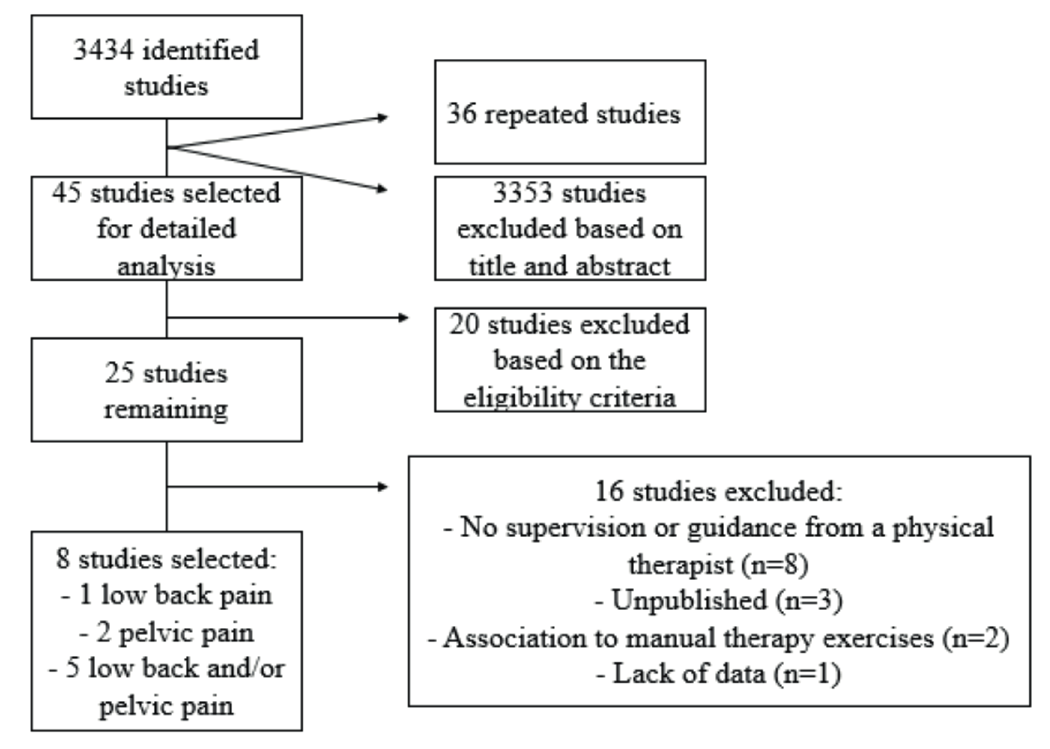
Figure 1 - Flowchart of the research and selection of the studies included in this review Note: n: number of